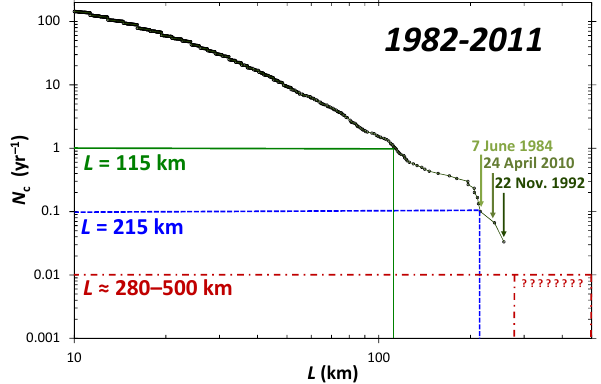
Fig. 2. Cumulative number of continental USA tornadoes per year N c with path lengths greater than or equal to L is given as a function of L . The data (NOAA, 2012) are for the period 1982–2011 and for L ≥ 10km, defined in this paper to be severe tornadoes. The three longest path lengths are identified by vertical arrows. Using this data, rough estimates are made for the expected 1-yr, 10-yr, and 100-yr